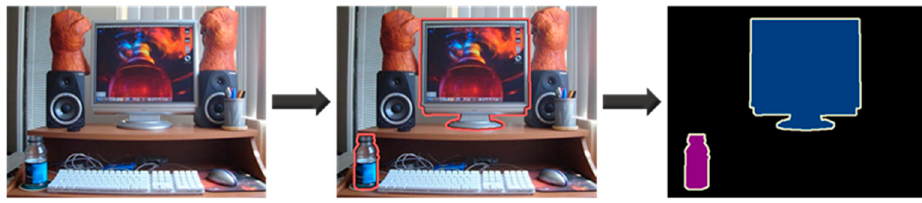
Figure 2. General semantic segmentation image acquisition process.